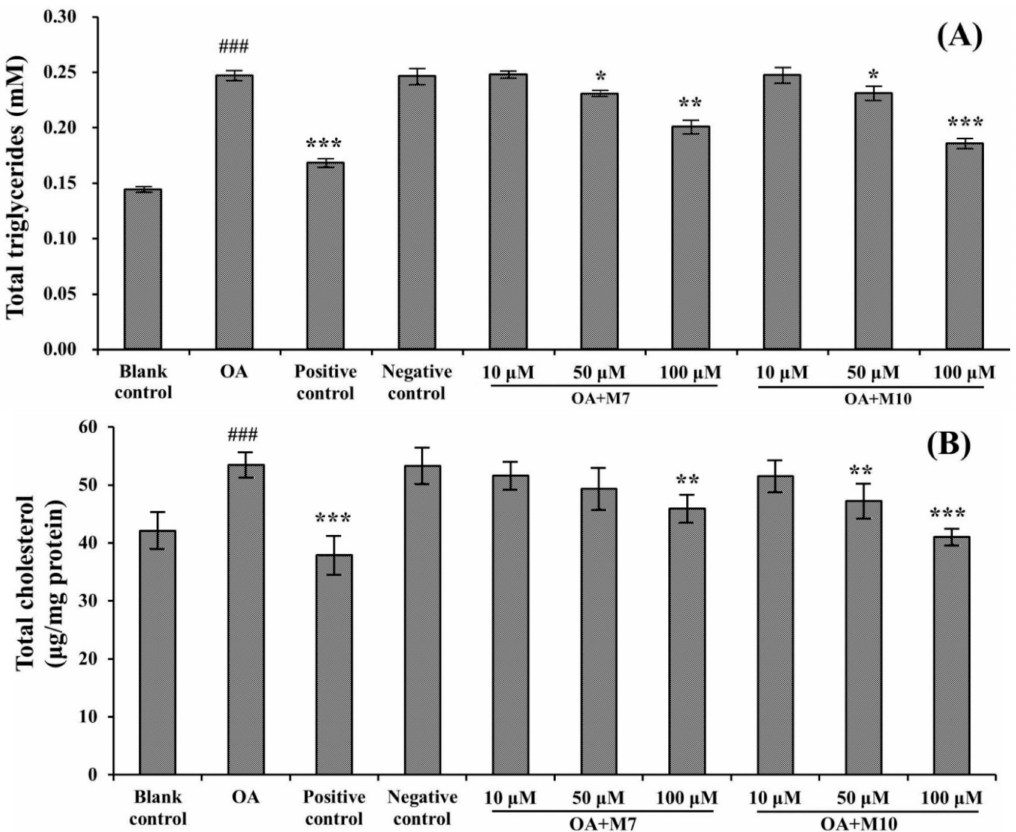
Figure 4. E ff ects of VIAPW (M7) and IRWWW (M10) from miiuy croaker ( M. miiuy ) muscle on the intracellular contents of total triglycerides (TG) ( A ) and cholesterol (TC) ( B ) in HepG2 cells at the concentrations of 10, 50, and 100 µ m. Simvastatin (SV) and FMPLH (M5) were used as the positive control and negative control, respectively. Means ± SD (n = 3) are used to express the experiment data. ### p < 0.001 versus control group; *** p < 0.001, ** p < 0.01, * p < 0.05 versus OA model and negative control